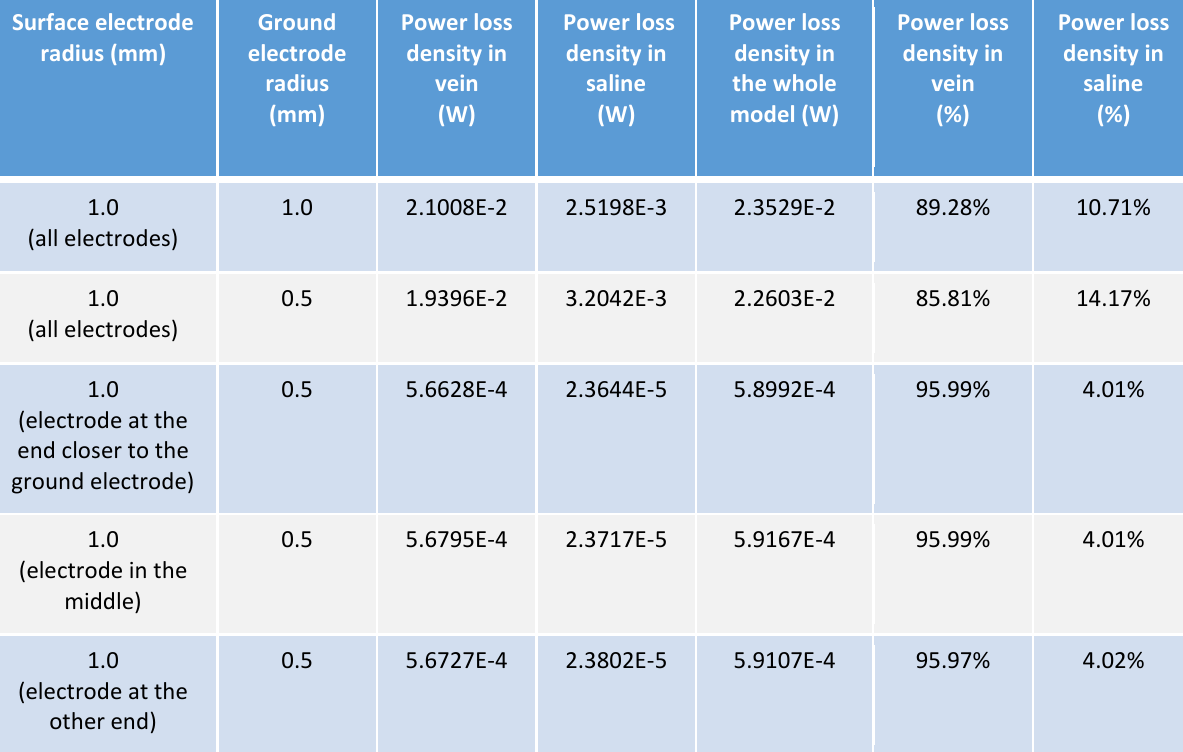
Table.14: Volumetric power loss density measurements at 1MHz with both all and one of the 44 surface electrodes as terminal (11 electrodes in 4